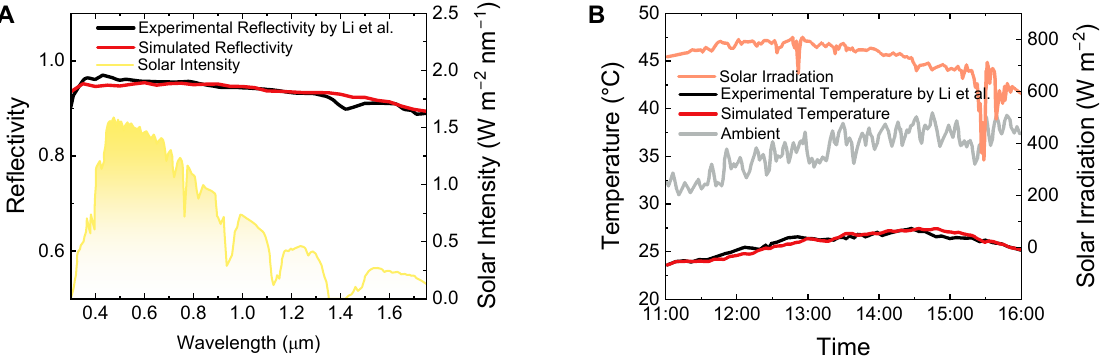
Figure 4. Validation of the optical model ( A ) and the thermodynamics model ( B ). The experimental data were obtained from Li et al. [24].